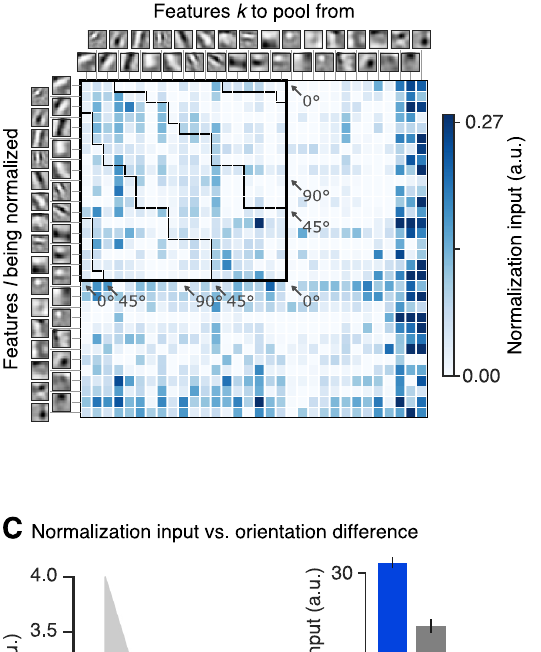
Fig 5. Structure of divisive normalization. A . The matrix shows the average strength of the normalizing inputs (products h p denominator of Eq (1) averaged across images; see Methods) for each combination of filter response being normalized (rows) and filter response providing normalizing input (columns). Darker shades of blue indicate stronger normalization. Orientation-selective filters are grouped at the top, ordered by preferred orientation and marked by the black square. The dashed black lines within the square separate pairs of filters with similar ( < 45˚) and dissimilar ( � 45˚) orientations. Normalizing inputs are stronger for similarly tuned filters. Unoriented filters mainly accounting for orientation-unspecific contrast are sorted by total normalization input. Darkest blue color corresponds to the maximum normalization input for the group of oriented filters, higher normalization input values for the unoriented filters are clipped to that value. Data of the model with highest accuracy on the validation set is shown. B . Normalization input from similar orientations ( < 45˚) compared to the normalization input from dissimilar orientations ( � 45˚) for each oriented linear filter. Grey line: identity. Most features are normalized preferentially by the responses of filters with similar preferred orientations. Data of the model with highest accuracy on the validation set is shown. C . Normalization input, binned into orientation difference of 10˚. Each bin was averaged over the top-10 models (assessed on the validation set). The shaded area depicts the standard deviation per bin. C inset . Normalization input (norm. input) vs. cosine similarity between linear filters (cos. sim.) averaged across the top-10 models (assessed on the validation set). A cosine similarity greater than zero corresponds to similar features. Error bars: standard error of the mean. D . Histogram of DN exponents ( n l in Eq 1) of the ten best performing models in terms of validation set accuracy. Darker/lighter color: exponents corresponding to driving inputs due to oriented/unoriented linear filters. Most values are larger than one, with a few exceptions mainly corresponding to unoriented filters.